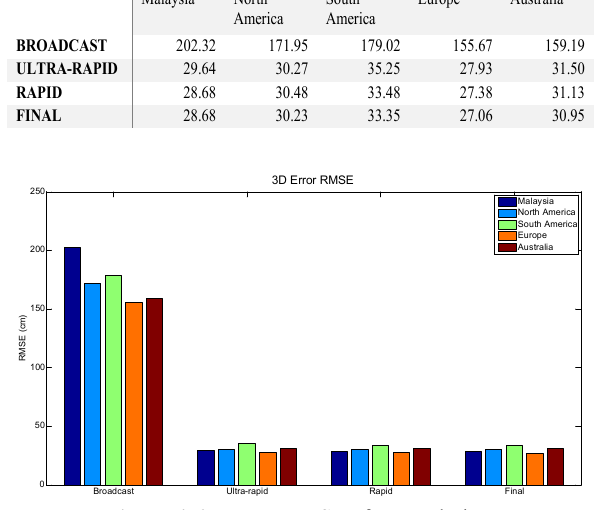
Figure 4. 3D Error RMSE of PPP